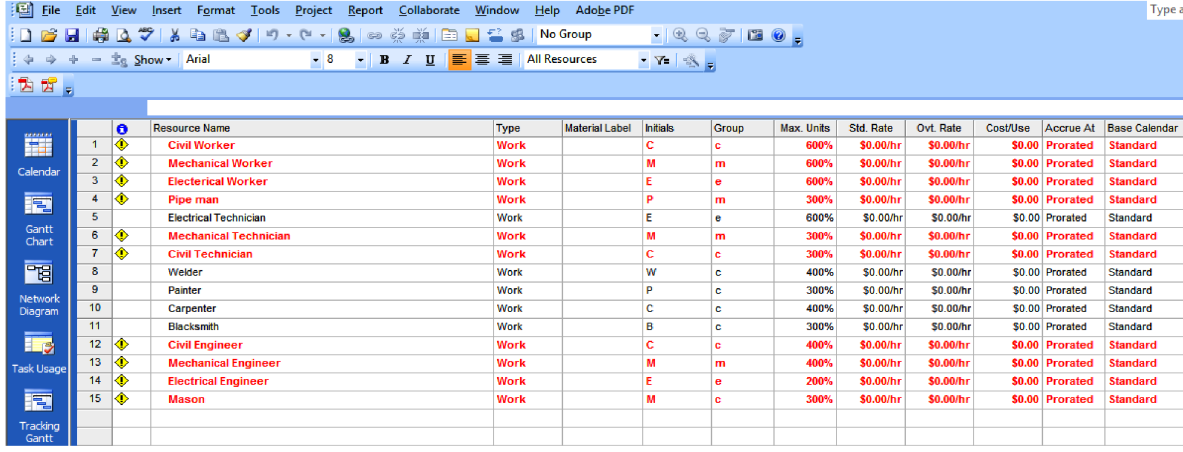
Figure 60. Resource sheet of MSP